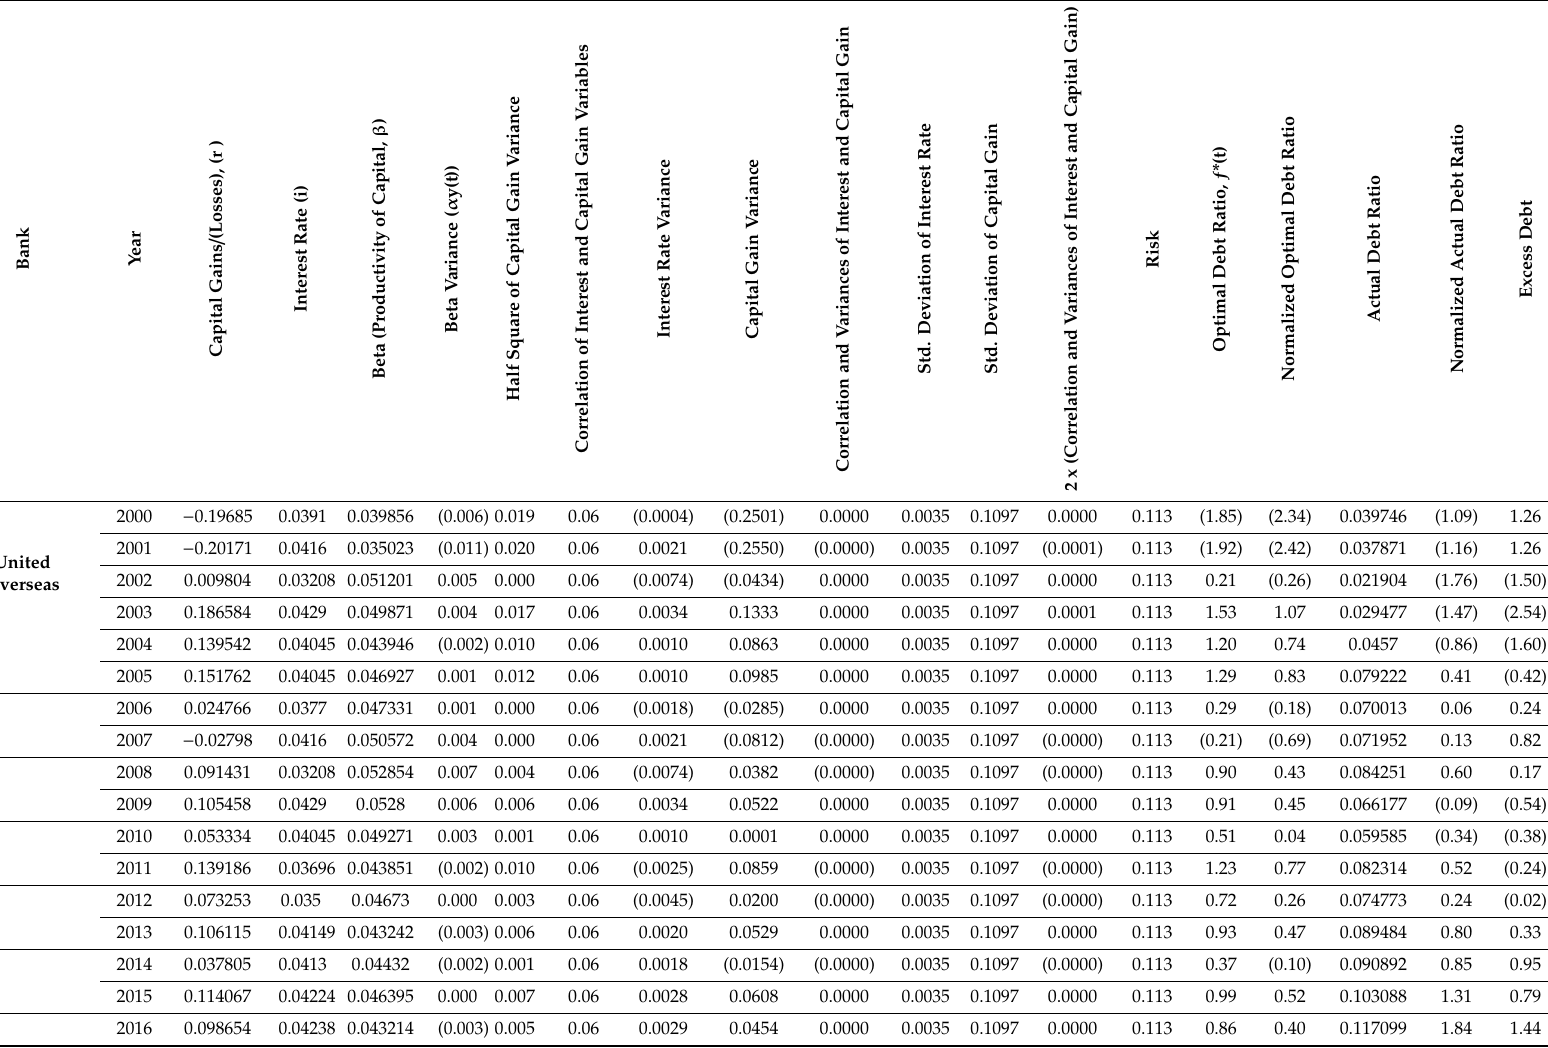
Table A10. Calculations of Optimal and Excess Debt: United